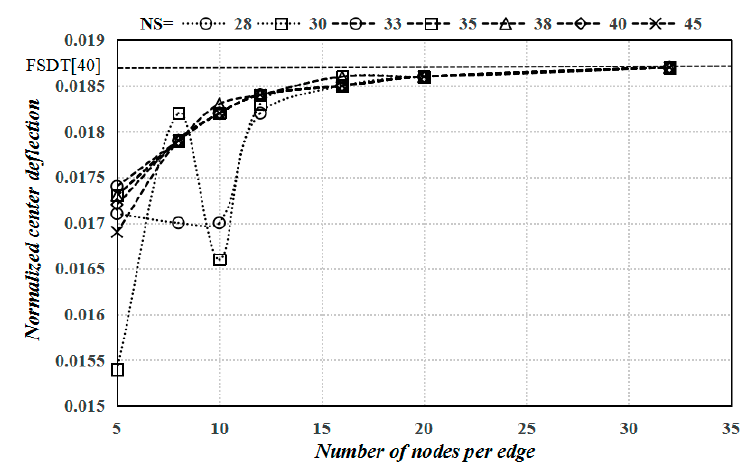
Figure 5. Convergence curves of normalized central deflection w ∗ = wE Al h 3 / q with di ff erent values of nodes of star in a local domain in an SSSS FG plate, with a / h =